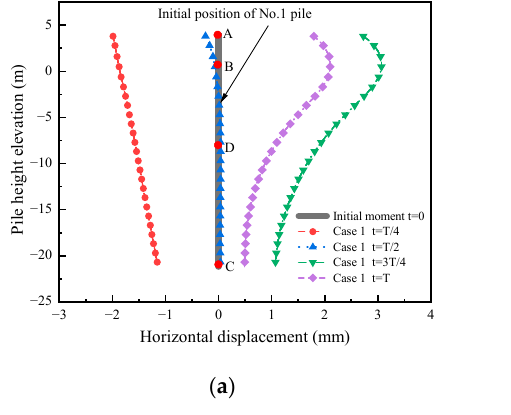
Figure 8. Horizontal displacement of the No. 1 pile under three cases: ( a ) Horizontal displacement of No. 1 pile in one tidal action period. ( b ) Horizontal displacement of No. 1 pile when the water level suddenly rises and drops.